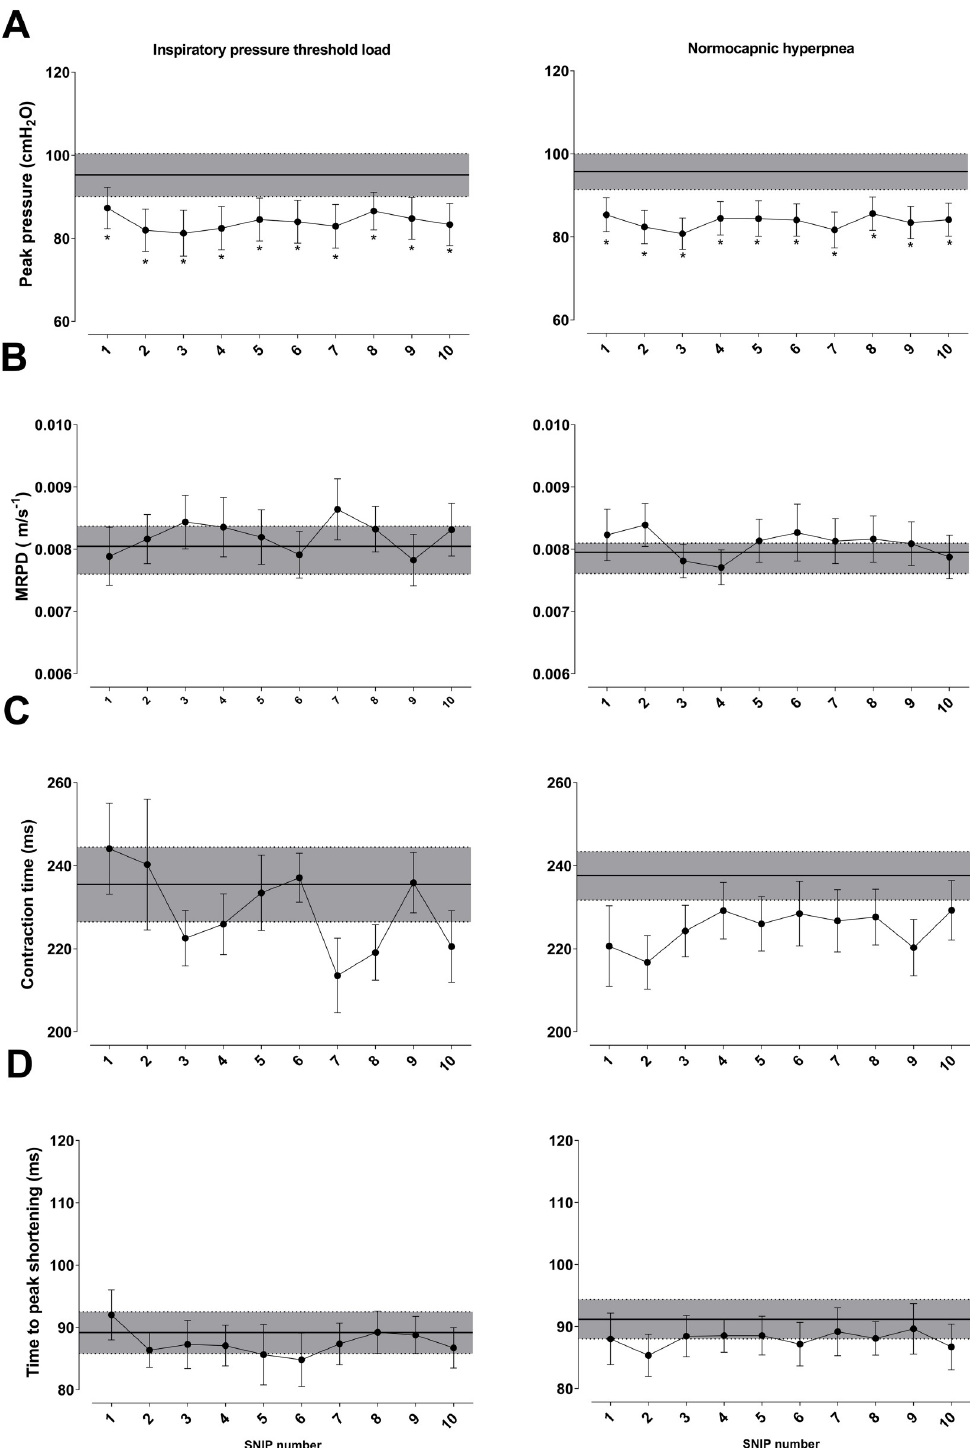
Fig 5. Changes in peak pressure of SNIP (panel A), maximum rate of pressure development (MRPD-panel B), contraction time (CT-panel C), and time to reach MRPD (TPS-panel D). Comparison of values during recovery from endurance test and pre-test (gray band). Data presented as mean ± SE. Abbreviations: cmH 2 O: centimeters of water; ms: milliseconds. � Statistically significant intragroup difference between pre-test and recovery p < 0.05.